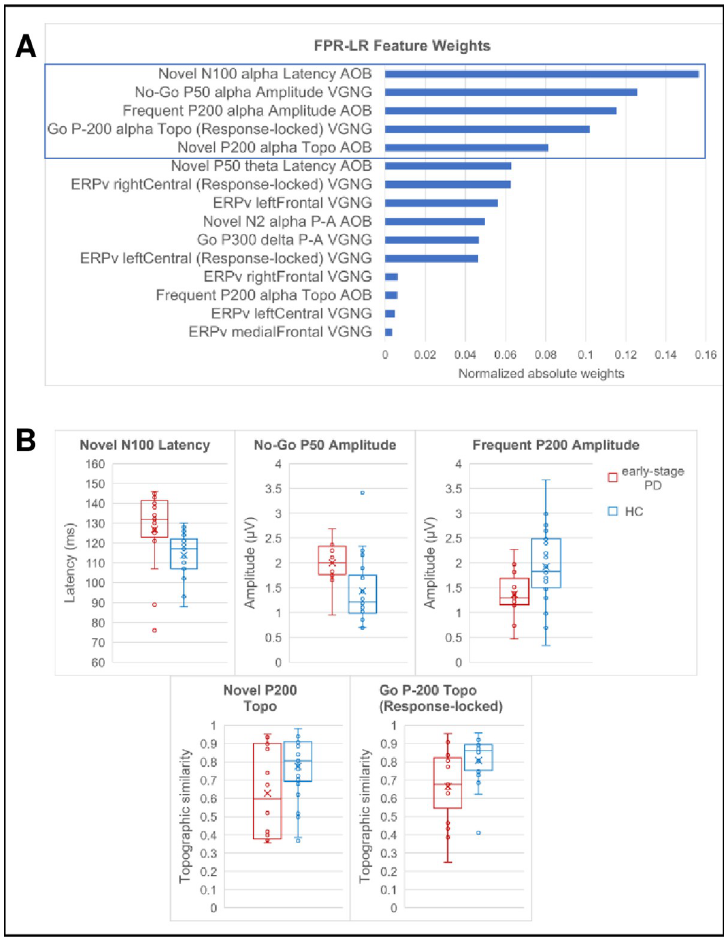
Fig 2. Features of the BNA neuromarker. (A) Weights of the BNA neuromarker features. The box indicates the five most important features. Weights are absolute value model weights normalized by their sum. (B) Box plots of the BNA scores of the five most important neuromarker features in participants with ESPD and HC. See Fig 1 for boxplot description. Points outside the whiskers are outliers, exceeding 1.5 times the interquartile range below the 1st quartile or above the 3rd quartile. Values are provided in S1 Table. AOB, auditory Oddball; VGNG, visual Go/No-Go; Topo, topographic similarity; ERPv, event related potential variability; μ V, micro volts; ms,